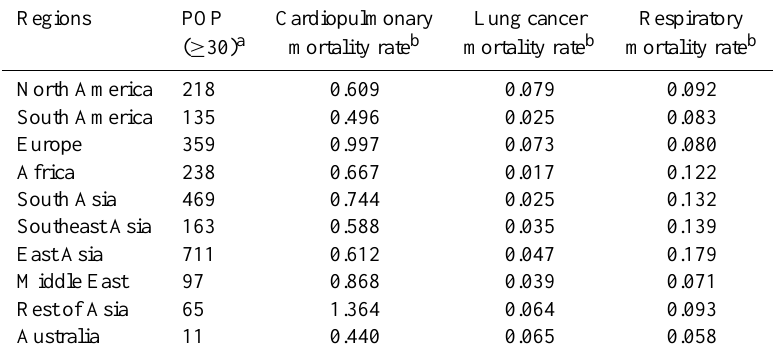
Table 2. Regional statistics for population and mortality rates. Population aged 30 and older (unit: million), cardiopulmonary, lung cancer and respiratory mortality rates (unit: % per year) for regions used in this study.